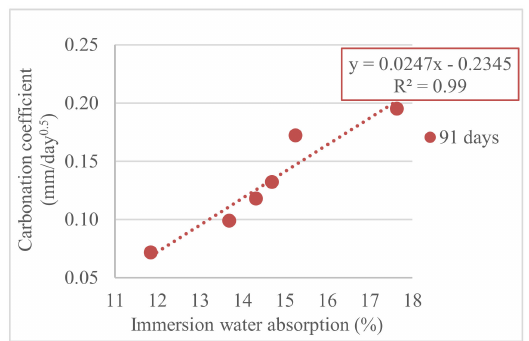
Figure 20. Relationship between the carbonation coe ffi cients and immersion water absorption results at 91 days.